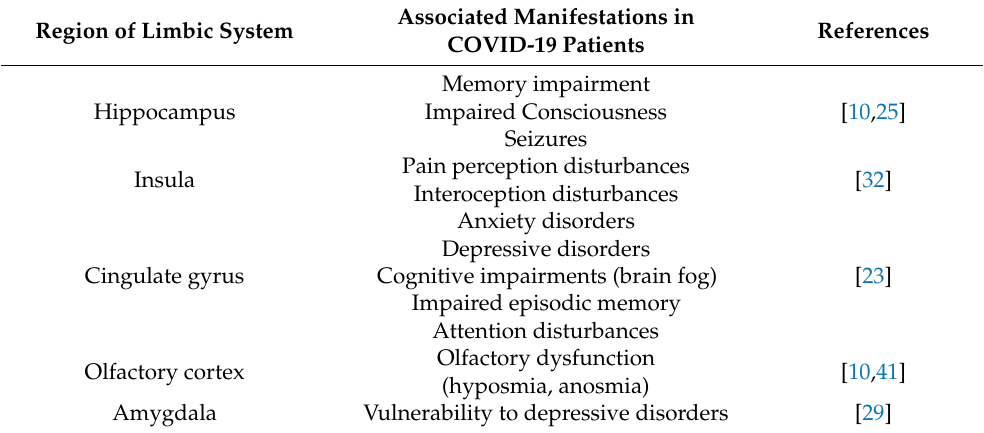
Table 1. Regions of the limbic system affected in COVID-19